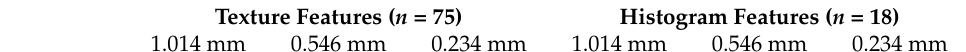
Table 2. The percentage of significantly different texture and histogram features among different parameters for images of various anisotropic resolutions and orthogonal slice directions compared to isotropic resolution. Post-contrast T1-weighted images, FP , and τ i maps demonstrate higher sensitivity to changes in slice thickness (30.7–46.7% of significantly different features at 0.234 mm) compared to v e , v p , PS , and K trans maps (0–5.3%). Similarly, histogram features from different parameter maps demonstrate different sensitivity to resolution change, where v e , v p , and FP maps with slice thickness of 0.234 mm show 0–16.7% significantly different features compared to isotropic resolution, and where FP , PS , τ i , K trans , and T1-w images range from 27.8–38.9%. Slice direction generally impacts the distribution of significantly different features similarly, with the notable exception of post-contrast T1-weighted images, where the sagittal direction impacts 58.7% of texture features compared to 20% and 10.7% of features for the axial and coronal directions, respectively. Percent of Features Demonstrating Significant Difference from Isotropic Resolution Texture Features ( n = 75) Histogram Features ( n =